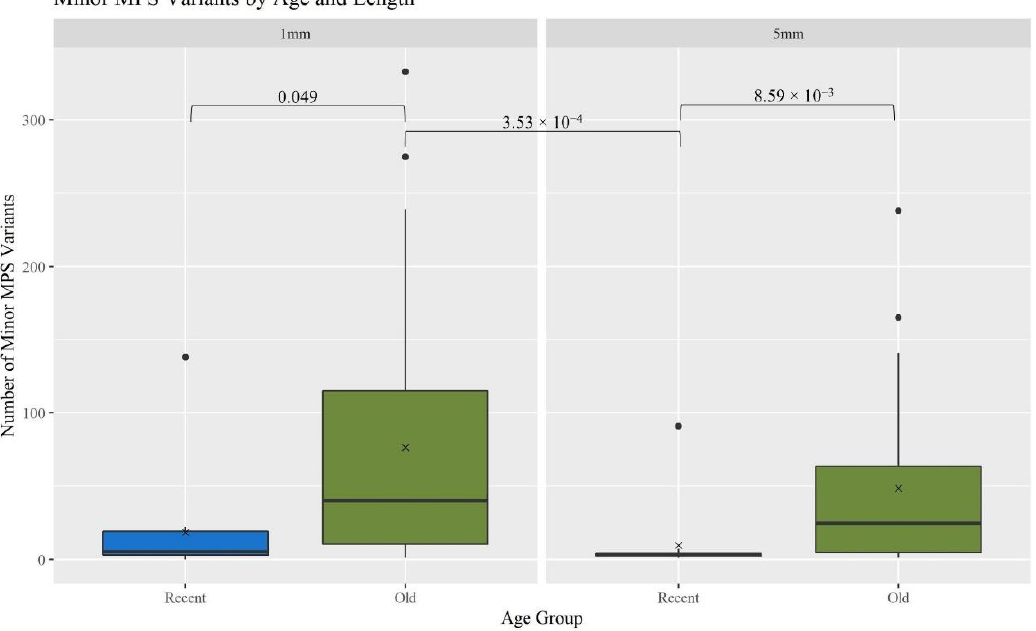
Figure 5. Linear regression of the number of reported minor MPS variants compared to the calcu- lated degradation index for each age group and length (n = 74; n R = 26, n O = 48).